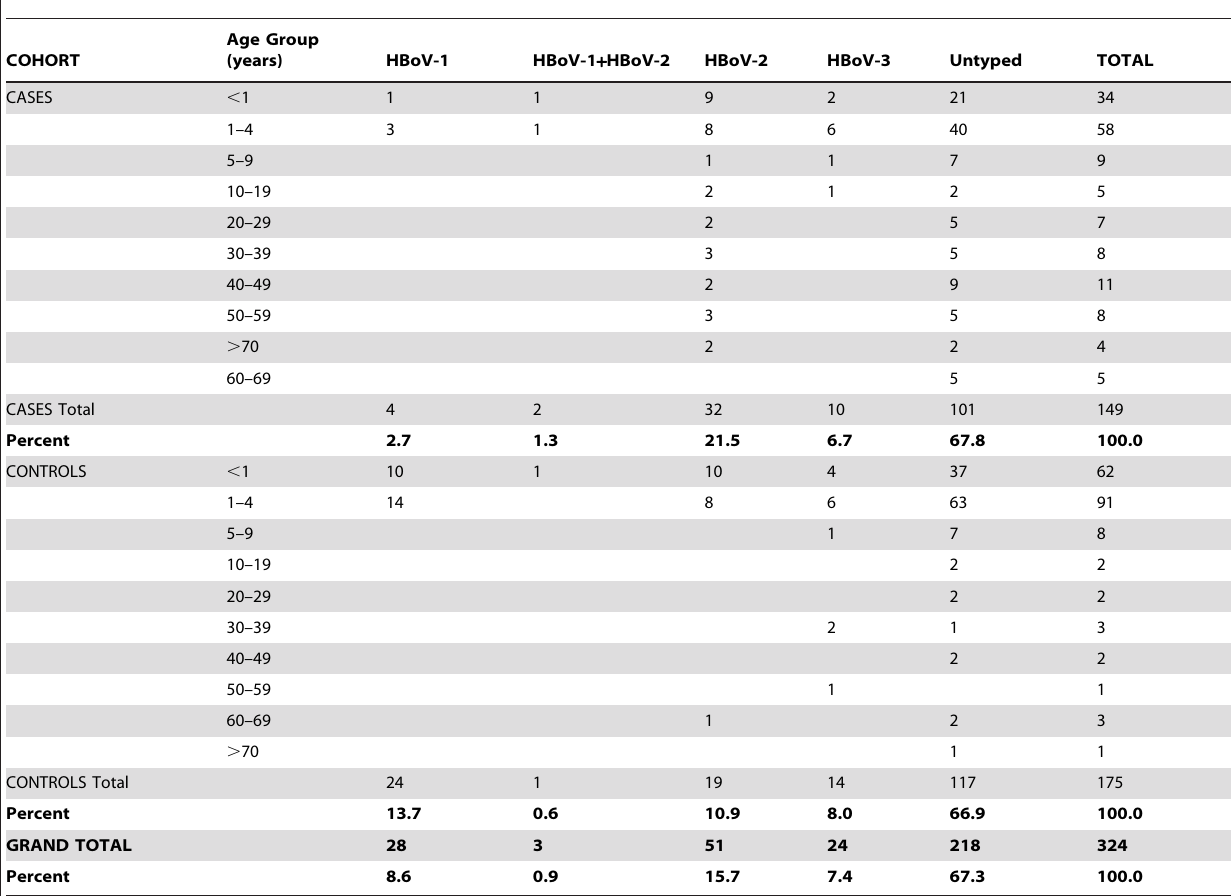
Table 4. Distribution of HBoV genotypes in cases and